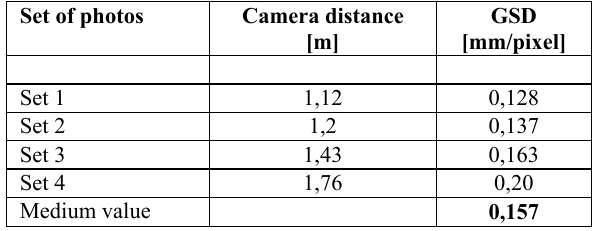
Table 1 . Calculation of ground sample